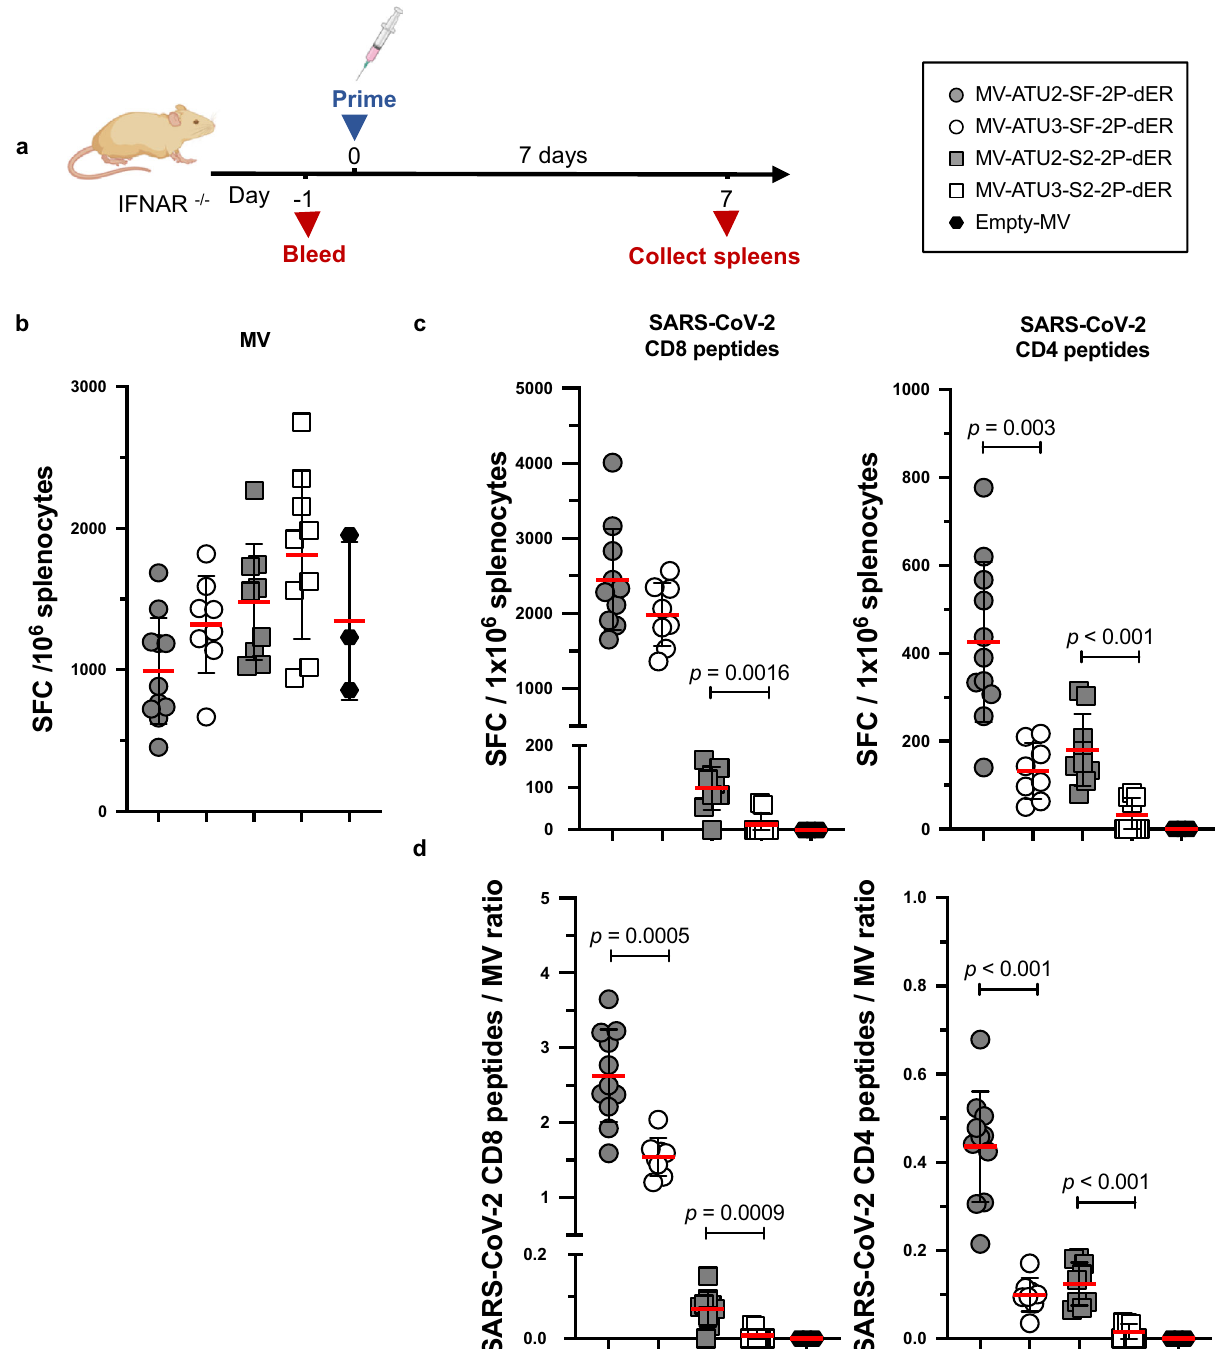
Fig. 4 Induction of S-speci fi c cellular responses by rMV vaccination. a IFNAR − / − mice were immunized by intraperitoneal injection with 1 × 10 5 TCID 50 of MV-ATU2-SF-2P-dER, n = 11; MV-ATU3-SF-2P-dER, n = 8; MV-ATU2-S2-2P-dER, n = 9; MV-ATU3-S2-2P-dER, n = 9 and Empty MV, n = 3. Seven days after immunization, ELISPOT for IFN γ was performed on freshly extracted splenocytes. The data are shown as IFN γ -secreting cells or spot-forming cells (SFC) per 1 × 10 6 splenocytes detected after stimulating with b MV Schwarz or c SARS-CoV-2 S peptide pools speci fi c to CD8 + or CD4 + T cells. d Ratio of IFN γ -secreting cells stimulated by CD4 + or CD8 + peptides to those stimulated by MV Schwarz. Each data point represents an individual mouse. Data are represented as mean with line and error bars indicating ±SD. Signi fi cant differences between the groups were determined by two-tailed the Mann – Whitney